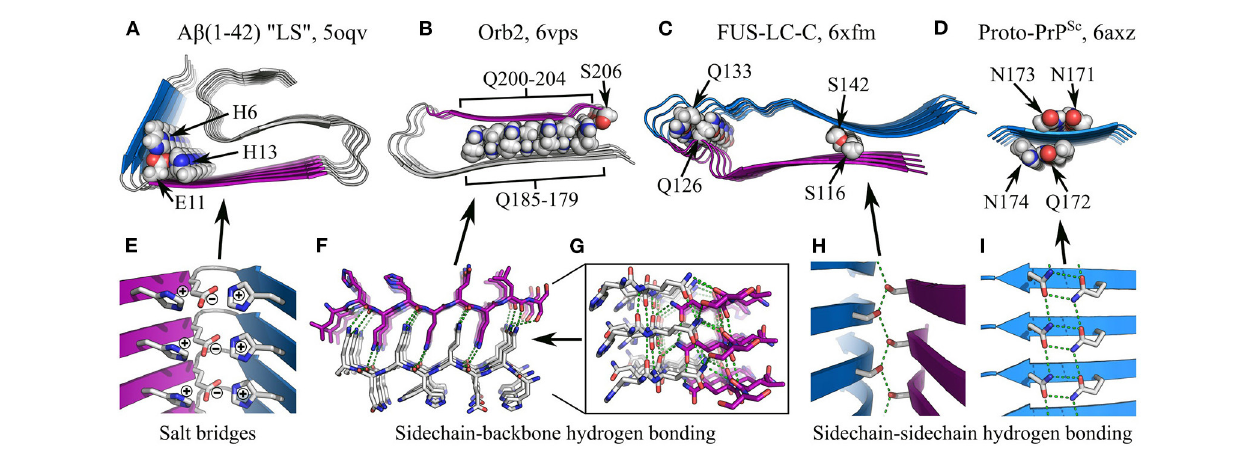
FIGURE 7 | Specific interactions in subunit folding. (A–D) show the structures of various individual protofilaments, with specific interactions highlighted: (A) , A β (1-42) “LS” polymorph, (Gremer et al., 2017), showing the H6-E11-H13 salt bridge; (B) , Orb2 (Hervas et al., 2020), with sidechain-backbone hydrogen bonding by interdigitated glutamines, and sidechain-sidechain hydrogen bonding between Q179 and S206; (C) , FUS-LC-C ( Lee et al., 2020), with sidechain-backbone hydrogen bonding from the sidechain amide of Q126 to the backbone carbonyl of Q133, and sidechain-sidechain hydrogen bonding between S116 and S142; (D) , amyloid-like microcrystals of the prion-derived proto-PrP Sc peptide ( Gallagher-Jones et al., 2018), showing intra-strand sidechain-sidechain hydrogen bonding (“polar clasps”) by the residue pairs N171-N173 and Q172-N174. The name of the polypeptide is given above each structure, alongside the polymorph in quotes where relevant, and the PDB ID. Structures are shown as ribbon diagrams, with chain segments colored gray, blue, or purple for discrimination. Sidechains of interest are highlighted as spheres, with the color scheme: gray, carbon/hydrogen; red, oxygen; blue, nitrogen. For (B,C) , missing hydrogens have been modeled in. Throughout panels (A–D) , all structures use the same scale. (E–I) show close-up views of specific interactions in (A–D) . In (E,H,I) , structures are shown as ribbon diagrams with sidechains as sticks, using the same color scheme as (A–D) ; in (F–G) , both the backbone and sidechains are shown as sticks, with carbons in the Q200-S206 segment colored purple. For clarity, and consistency between structures with varying detail, hydrogens are not represented with sticks and are thus implicit. Hydrogen bonds are represented by green dashed